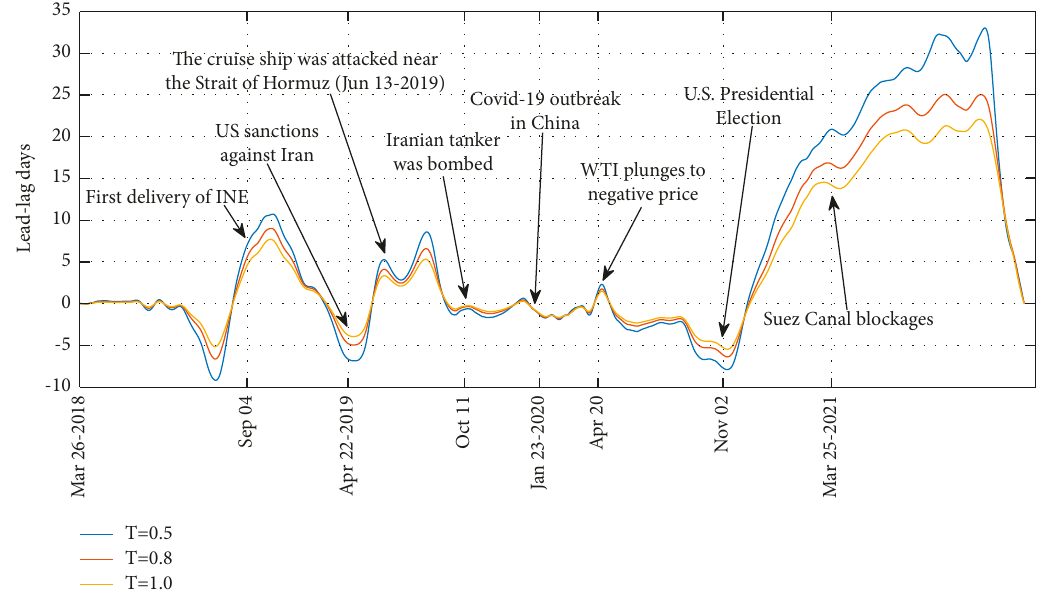
Figure 4: Leading-lag relationship between futures and